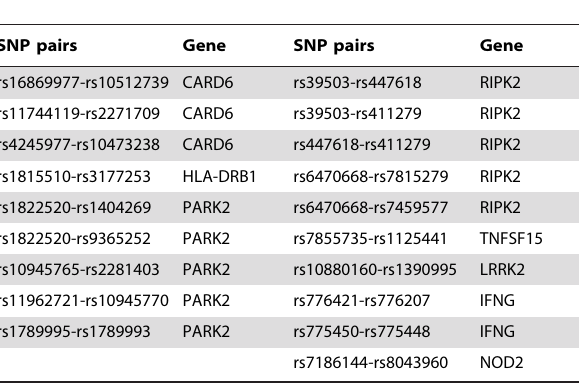
Table 3. Gene-gene co-association for SNP pairs ( p v 1 | 10 { 7 ) within 9 susceptibility genes belonging to the pathway associated with